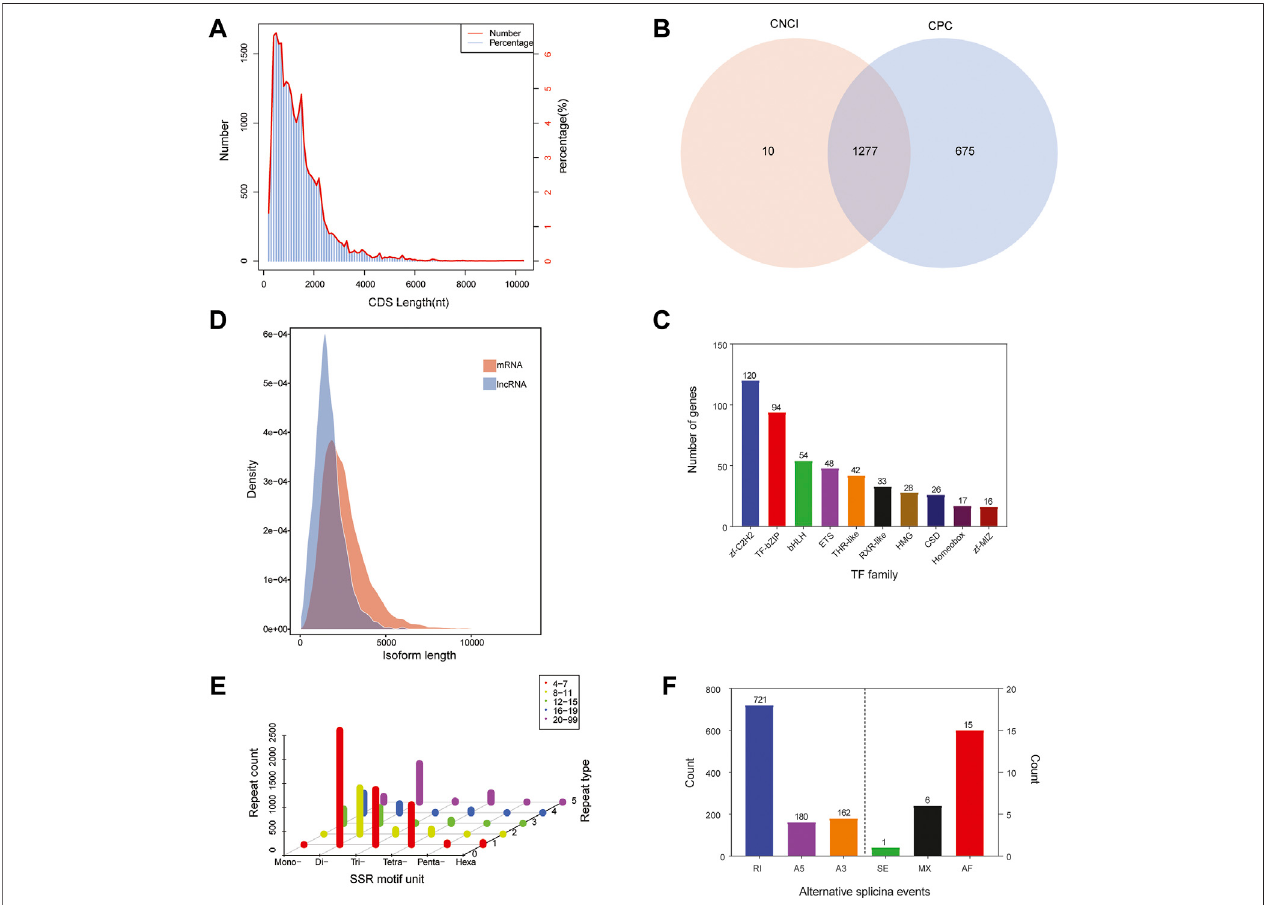
FIGURE 3 | Sequence structure analysis of Cipangopaludina chinensis . (A) Length distribution of CDSs. (B) Venn diagram of lncRNAs identi fi ed by the CNCI and CPC methods. (C) Length density distribution of the lncRNA and mRNA transcripts. (D) Families and numbers of the top 10 TFs produced by SMRT. (E) Summary of SSR types in the full-length transcripts of C. chinensis . (F) Alternative splicing events predicted by SUPPA.